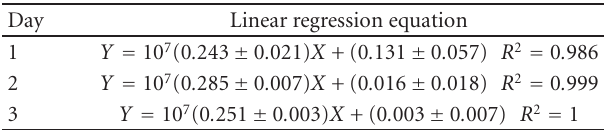
Figure 3: Calibration plot of the system with standard H 2 O 2 solutions in the field. Table 1: Linear regression results for stability of 5 μ M DCFH at room temperature.